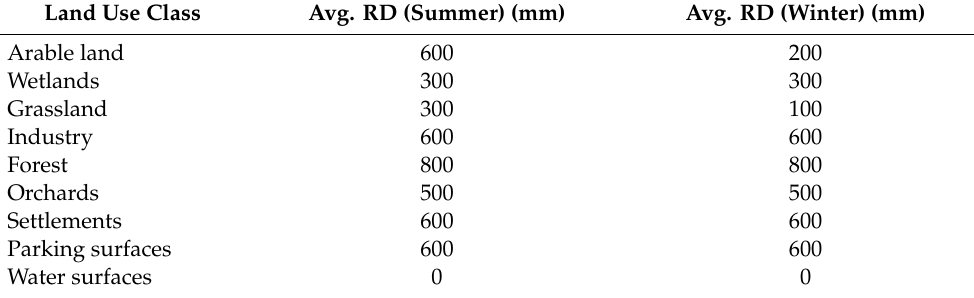
Figure 5. Average monthly variation of leaf area index used in Tollense river basin [44]. Table 2. Average RD during the summer and winter season in Tollense river basin [45].